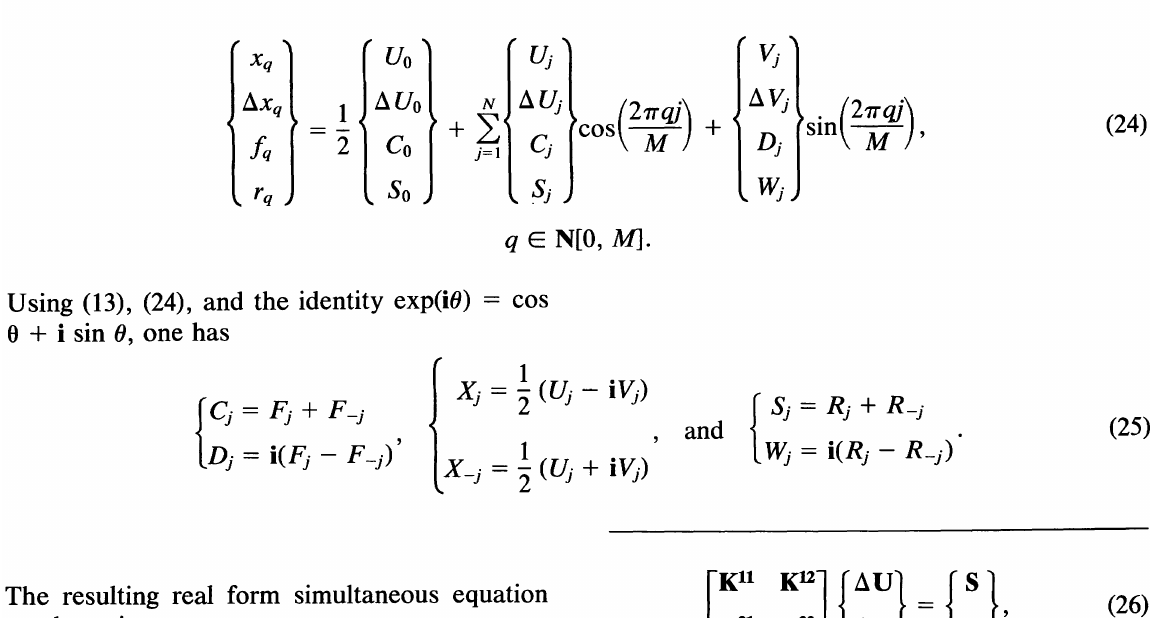
FIGURE 4 Comparison of CPU